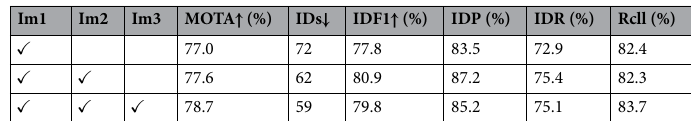
Table 3. Model ablation experiments on subsets of MOT15’s training